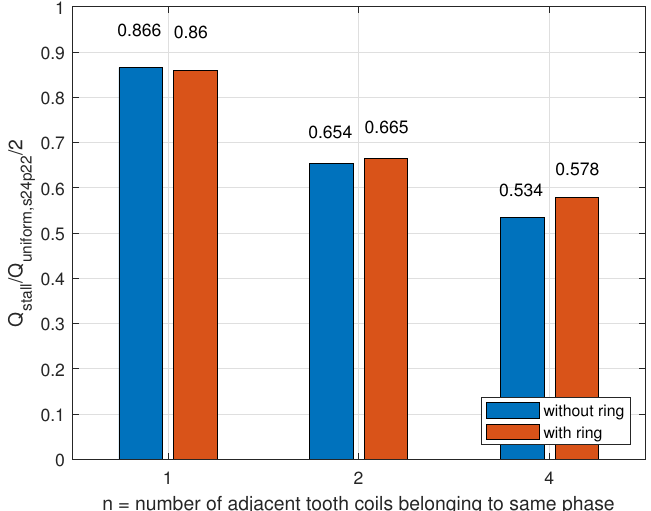
Figure 14. Measured ratio of the losses that can be dissipated in under stall torque conditions over the losses that can be dissipated in case of uniform loss distribution for various slot/pole combinations (see Figure 3) and for the cases with and without thermal end-winding